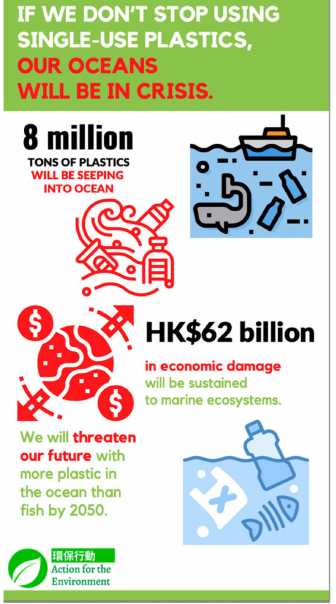
Figure A12. Example of condition 12: loss * infographic *